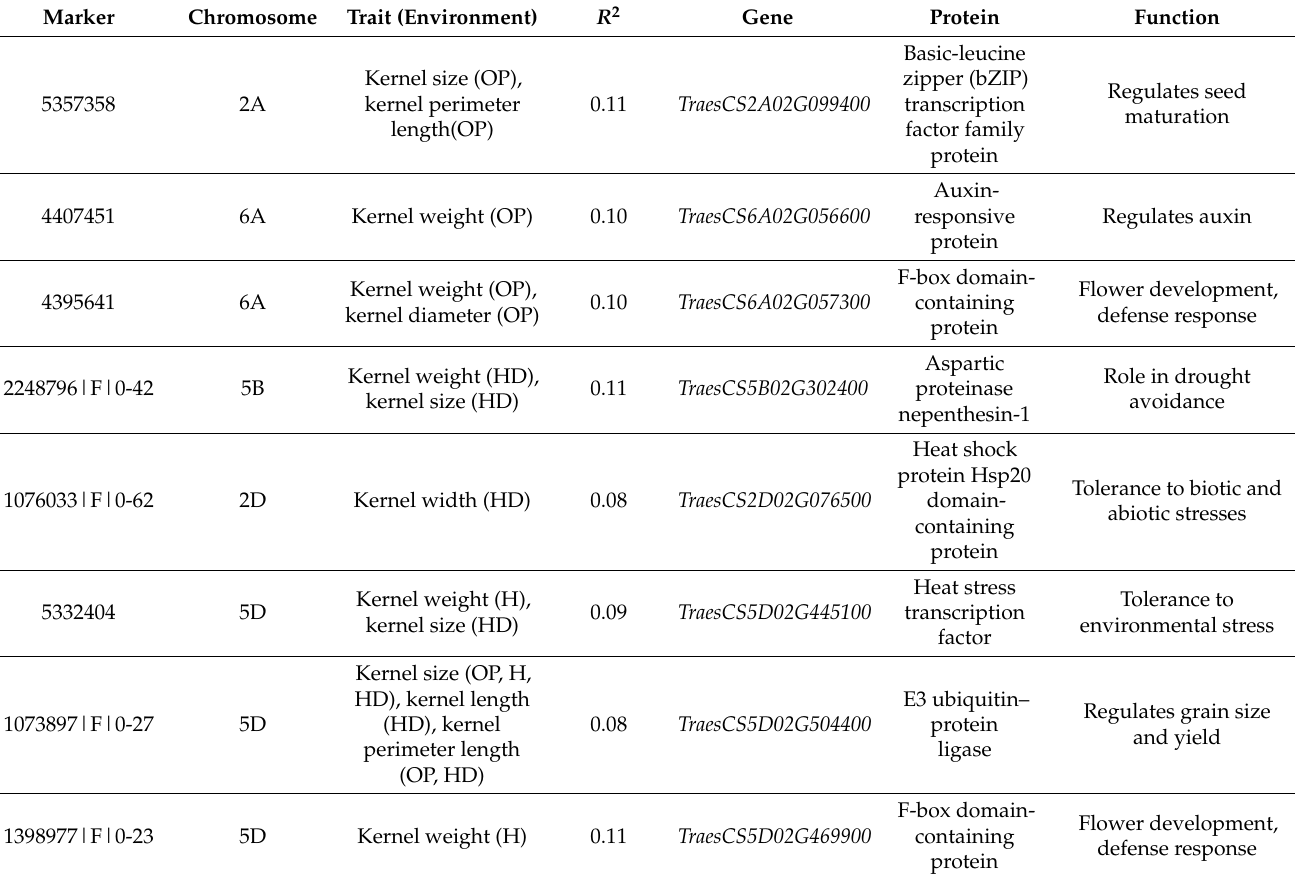
Table 3. Candidate genes for kernel weight and shape-related traits under optimum, heat and combined heat–drought conditions and their putative physiological